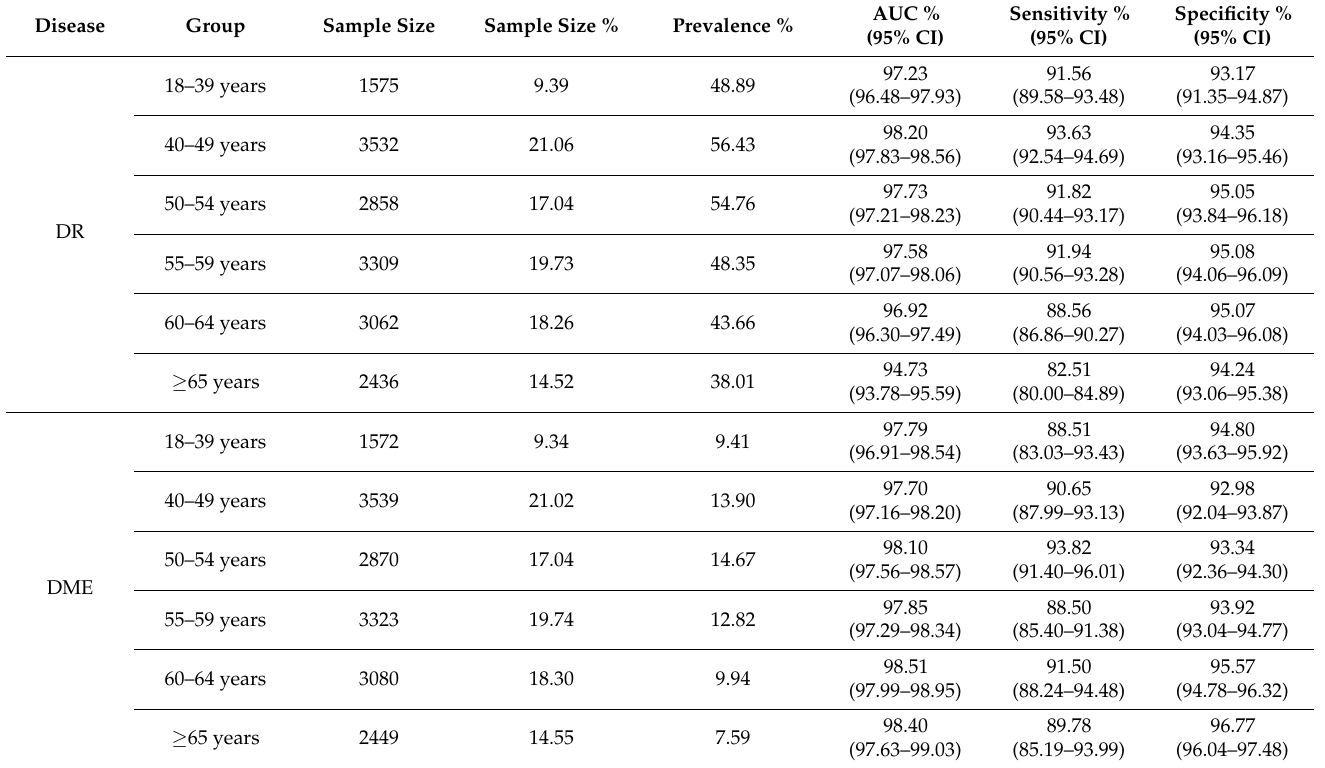
Figure A2. Examples of images of insufficient, adequate, good, and excellent quality. Table A1. Stratification results for detecting referable retinopathy and diabetic macular edema on the patient level per age